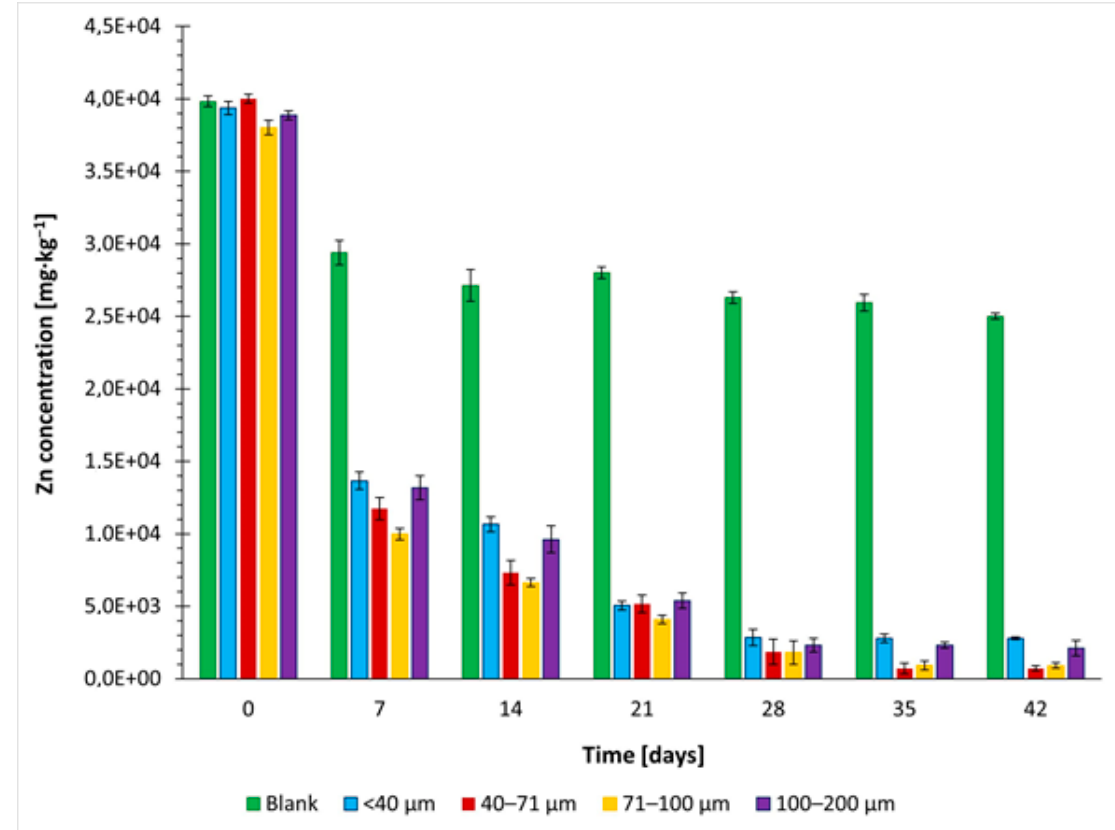
Figure 10. Concentration loss of Zn in waste material for the di ff erent grain